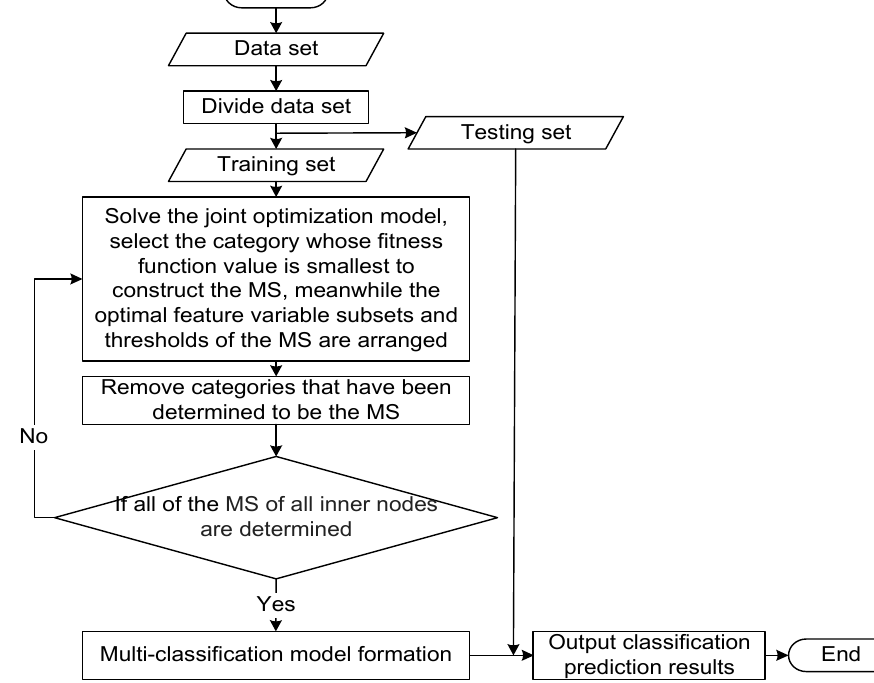
Figure 3. The schematic of the optimized BT-MTS.